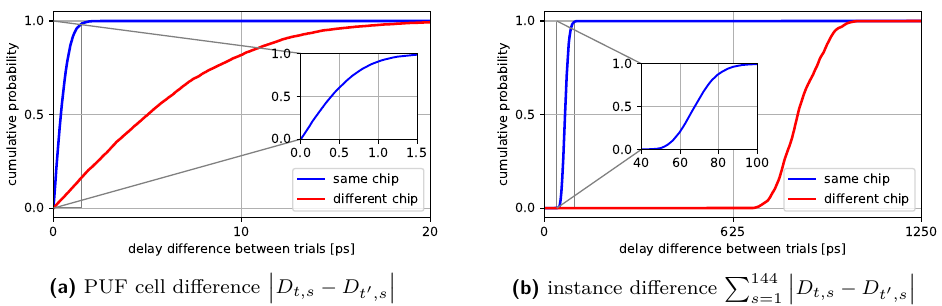
Figure 9: Cumulative distribution of within-class and between-class distance for individual PUF cells (a) and for entire chip instances when all 144 PUF cells are used (b). distance is 847.713 ps. Across the 10,000 randomly chosen comparisons of each type, the maximum within-class distance was 123.992 ps and the minimum between-class distance was 686.071 ps; the separation between these values is consistent with the PUF being a reliable and unique